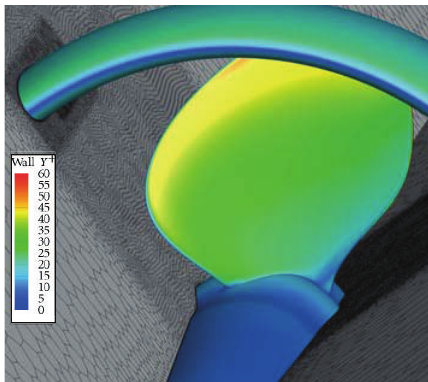
Figure 6: Wall Y + on propeller and duct—open water computa- tions at the design